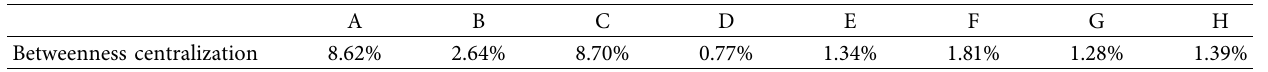
Table 6: Betweenness centralization of professional athletes’ social network.